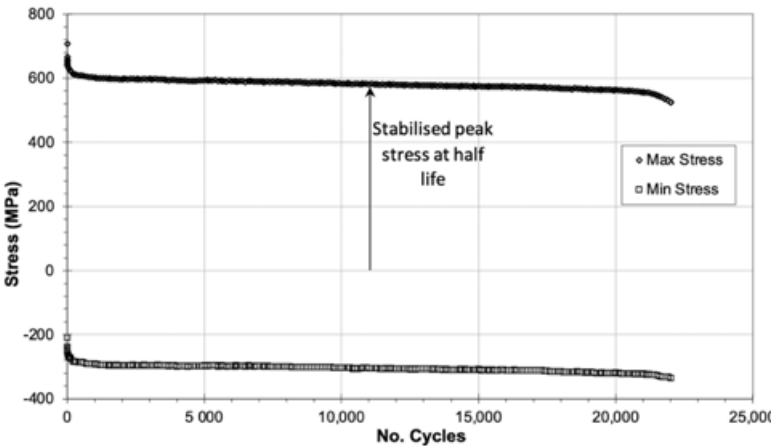
Figure 10. Bulk cyclic softening response under applied cyclic strain of 0.68%. Individual stress–strain loops are plotted from this test at N = 1, 2, 8 and 500 in Figure 11. Monotonic yield in this specific specimen, as defined during the initial cycle (N = 1), was at approximately 500 MPa followed by a substantial degree of plasticity to form the open σ - ε loop. Subsequent cycles essentially appear to behave in an elastic manner; however, progressive cyclic softening was represented by a gradual reduction in both the peak and minimum resultant stress.